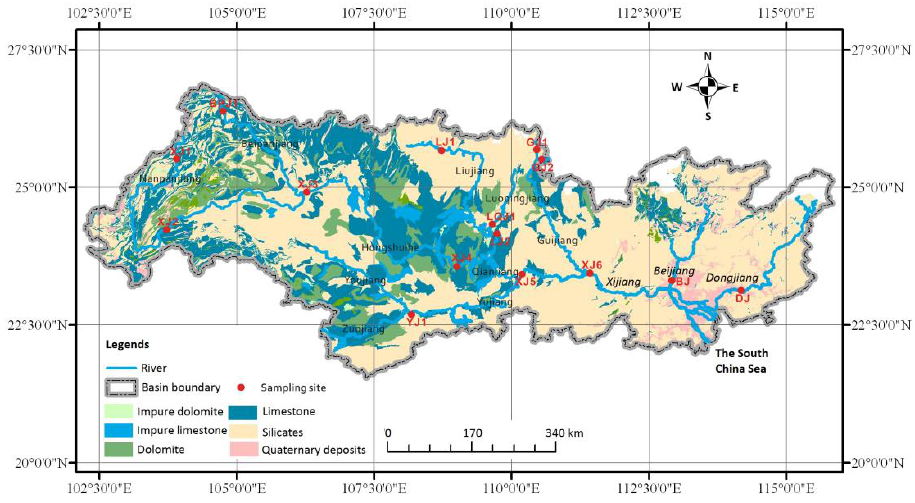
Figure 1. Geology of the Pearl River and sampling sites.